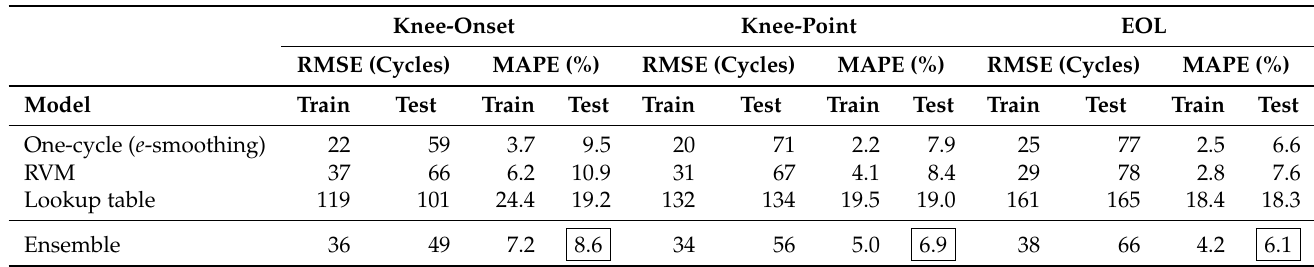
Table 4. Comparison of ensemble model with constituent models predicting from cycle 200. The Ensemble model outperforms each model individually as seen by the marked entries. Train metrics for the lookup table model are calculated using a leave-one-out approach. Metrics presented are for the Severson–Attia